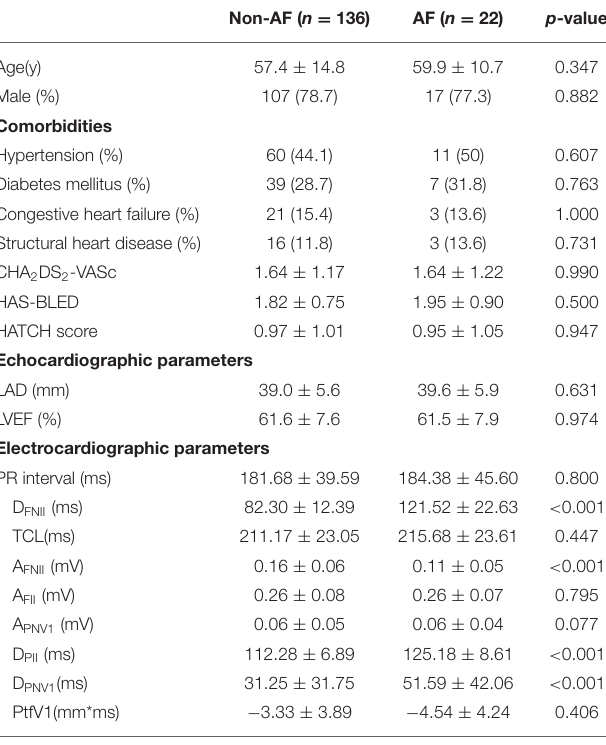
TABLE 1 | Comparison of the parameters between patients with and without atrial